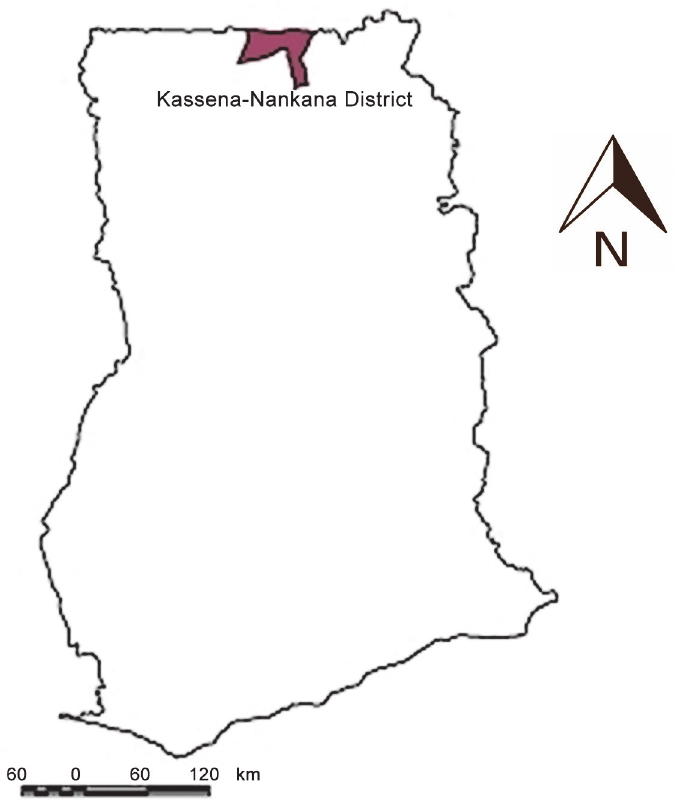
Fig 1. Map of Ghana indicating study area. Source: http://openi.nlm.nih.gov/imgs/rescaled512/2935923_ GHA-3-5233-g001.png (14/03/2015)